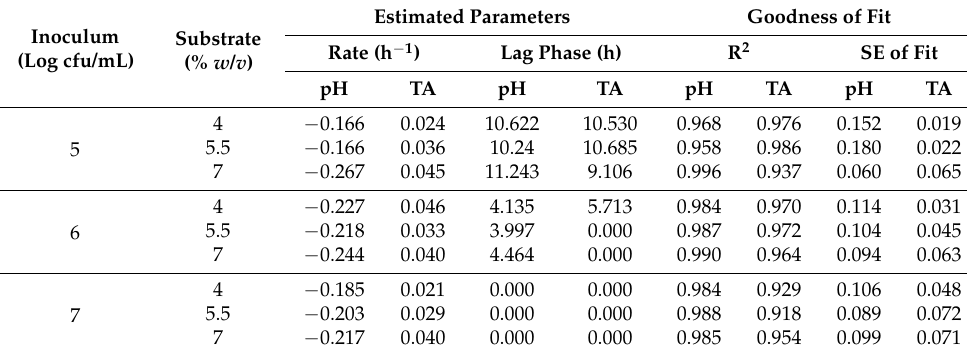
Table 3. DMFit estimated kinetic parameters of pH and TA in 24-h fermentation at 30 ◦ C. Inoculum (Log